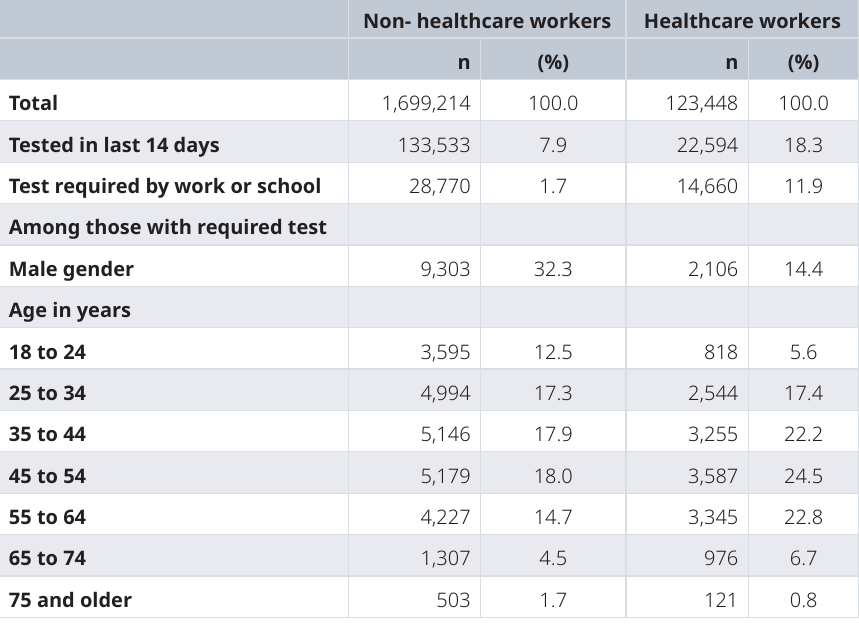
Table 1. Characteristics of survey